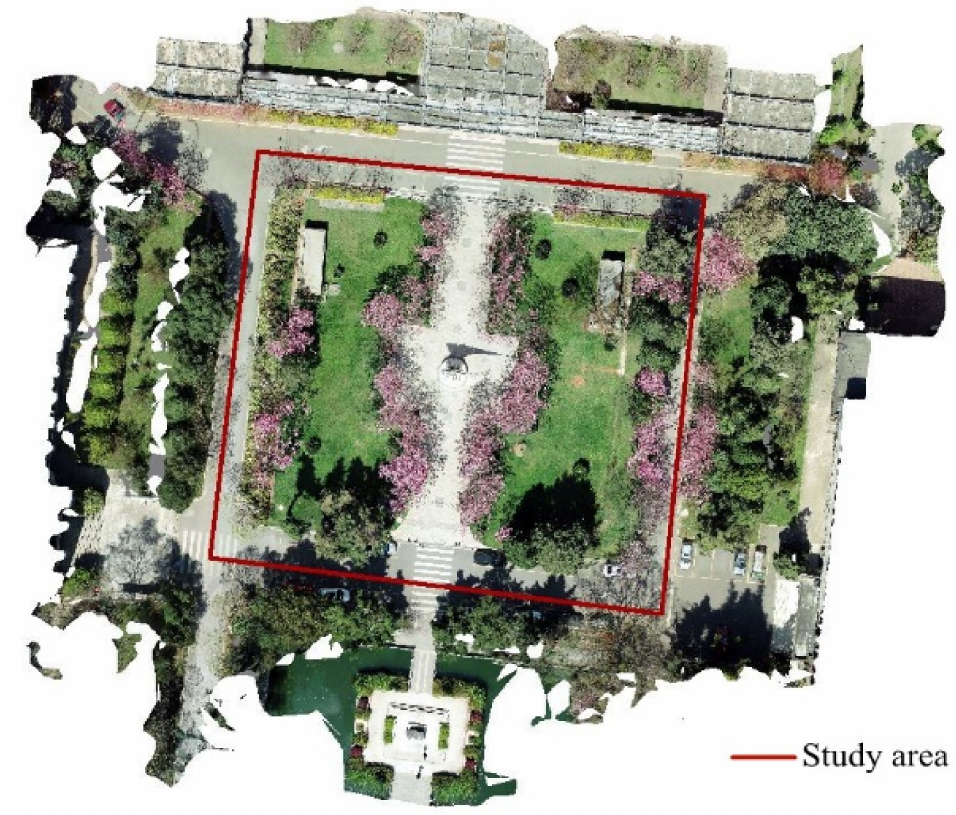
Figure 1. Location map of the study